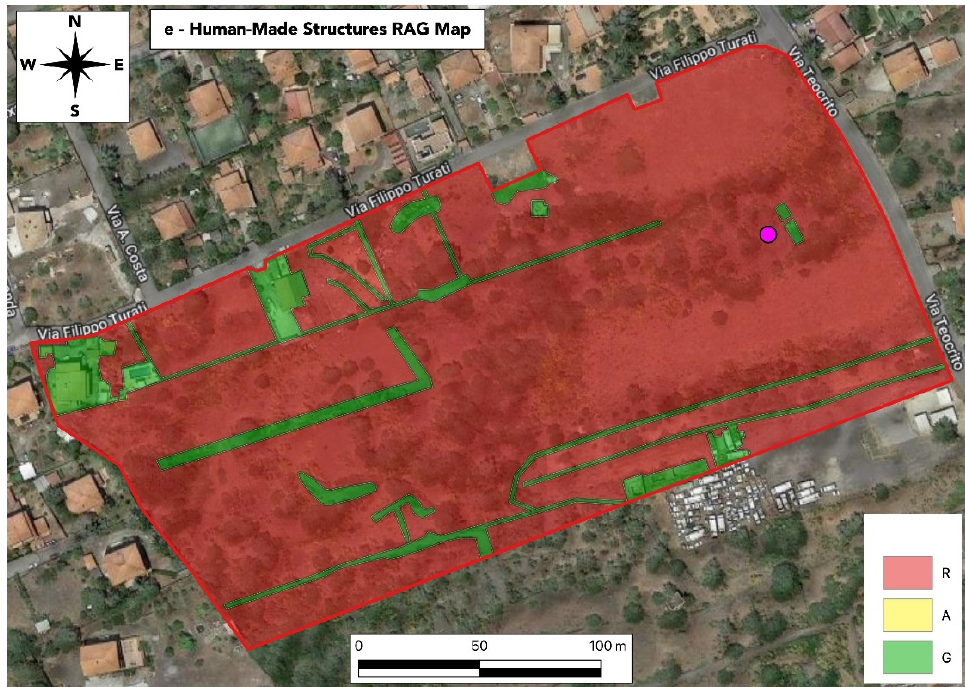
Figure 16. RAG map of the “Human-made structures” layer of the GIS platform. The burial site (pink circle) fell on the Red coded area. For the percentages of RAG color-coded areas see Figure 11 (the Amber-coded area is not visible covering the 3% along the Red and Green area boundary).